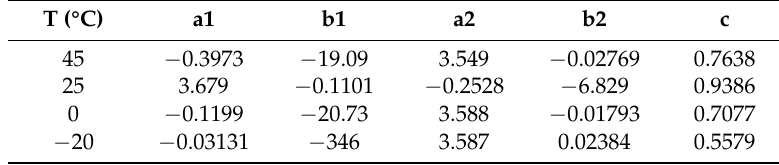
Table 2. The coefficient value of OCV‐SOC exponential model (n = 2) fitting under different temperatures. T (°C)